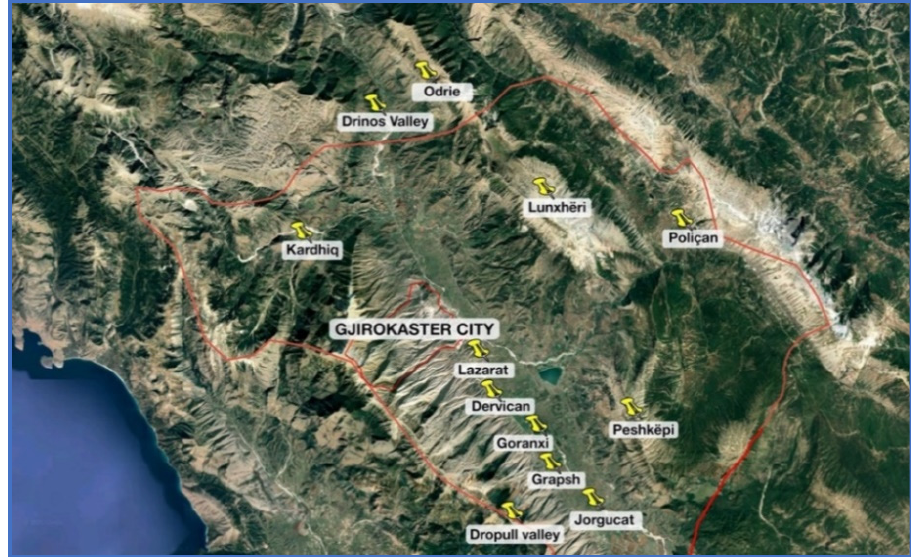
Figure 8. Locations of Gjirokastër in Albania and the quarries of stones.